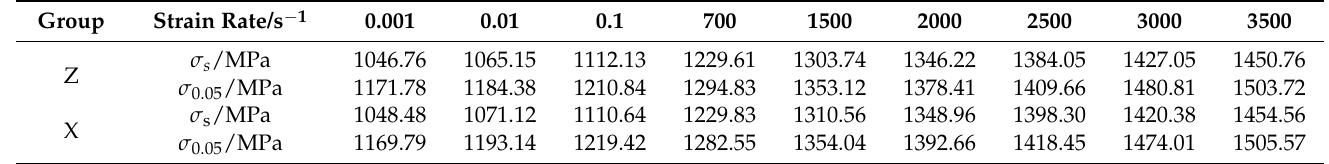
Table 2. Yield strength and flow stress of materials at different strain rates.